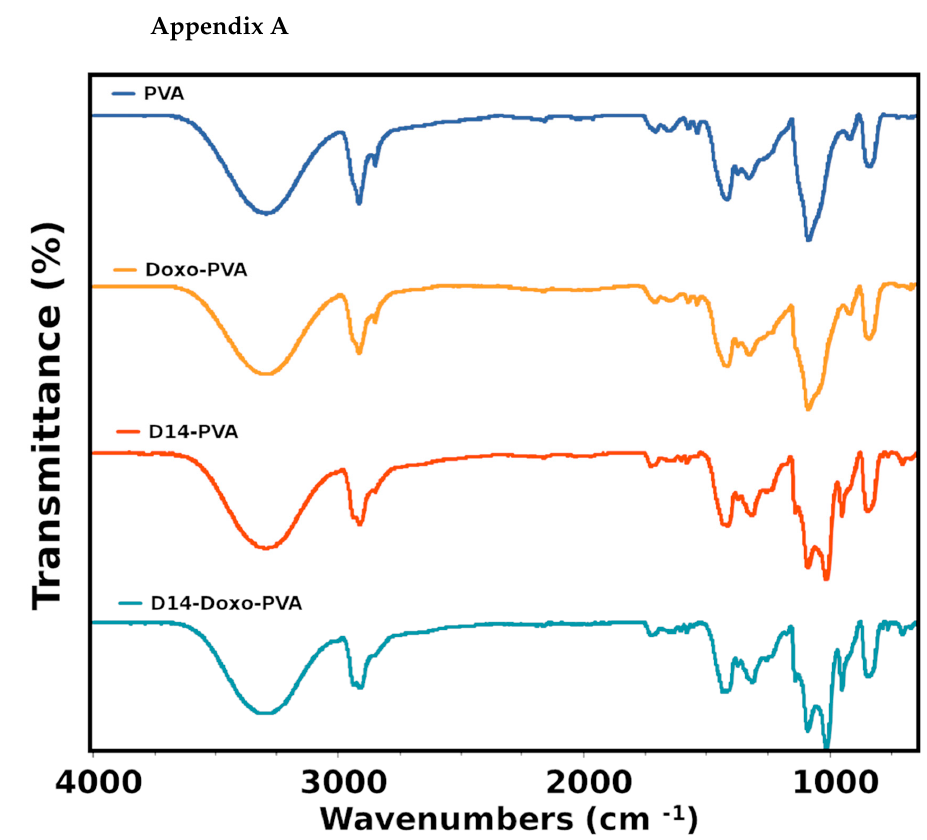
Figure A1. FTIR of the studied samples exhibiting the whole scanned region.